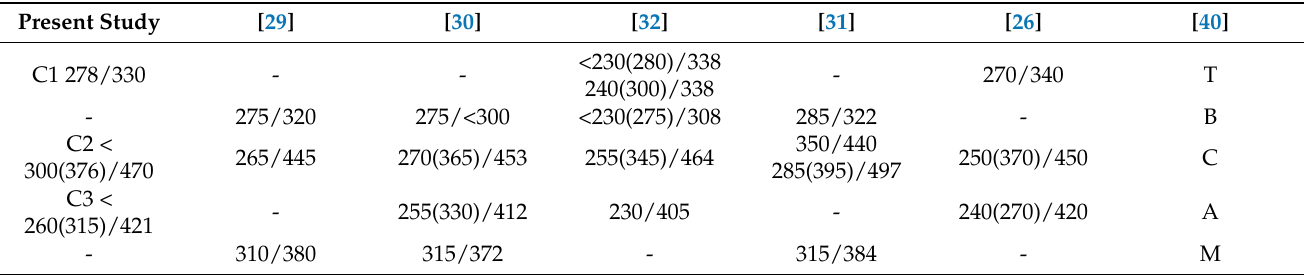
Table 2. Excitation and emission maxima of the four fluorescent components identified by PARAFAC modeling for the entire EEM data set, compared with previous PARAFAC